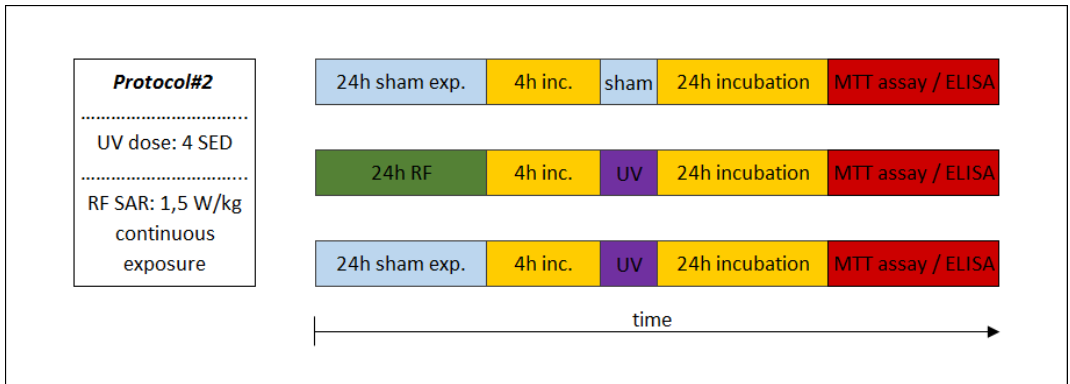
Figure 4. Experimental protocol of combined consecutive exposure for investigation of cooperative effects of exposure to RF and UV. Under Protocol#1, the skin tissues were first exposed to 2 standard erythemal dose (SED) UV and then 24 h 1950 MHz WCDMA (UMTS) modulated RF for 20 min on/off exposure with 4 W/kg SAR.